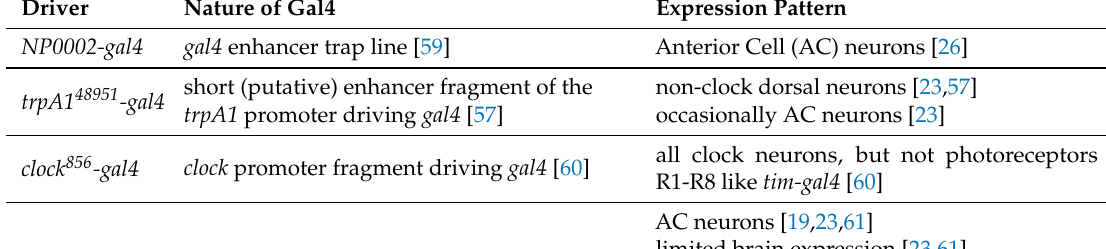
Table 1. Expression pattern of selected gal4 lines used to study the trpA1 circuit regulating siesta sleep.